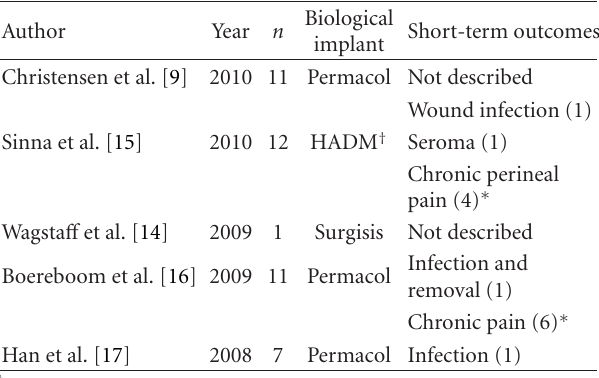
Table 1: Data describing reconstruction with a biological implant following cylindrical abdominoperineal